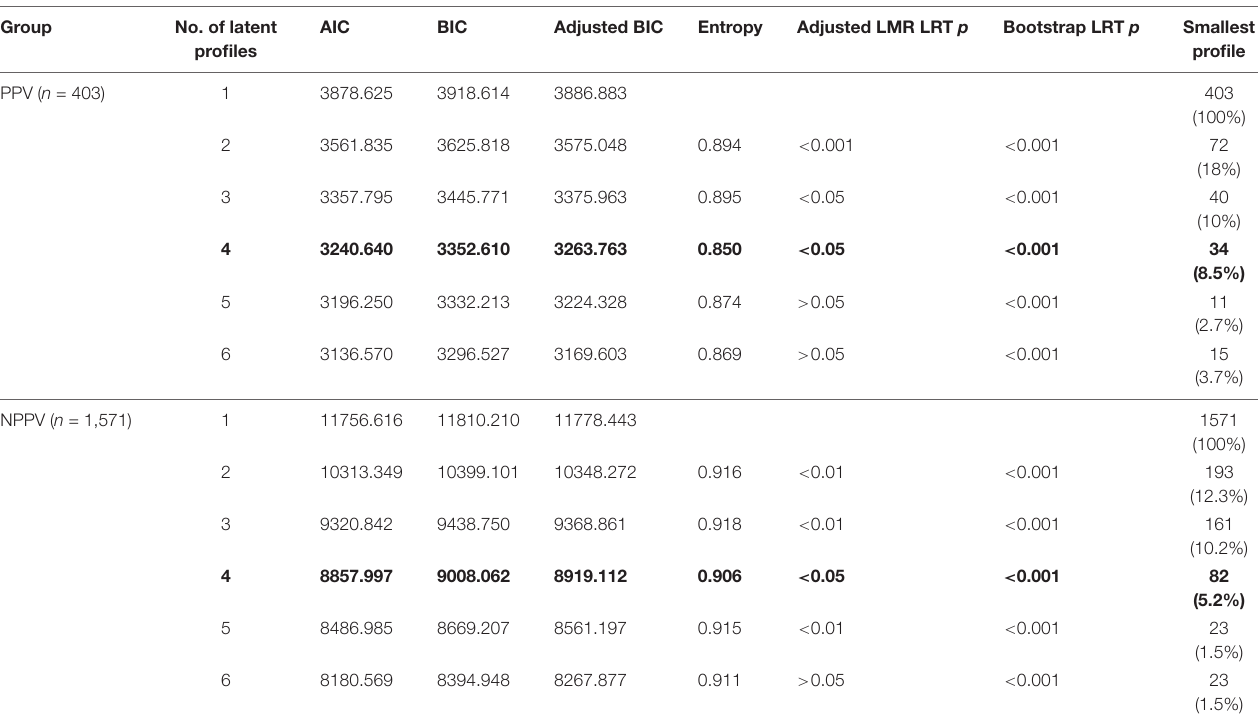
TABLE 2 | Model fit of the latent profile analysis for PPV and NPPV groups.